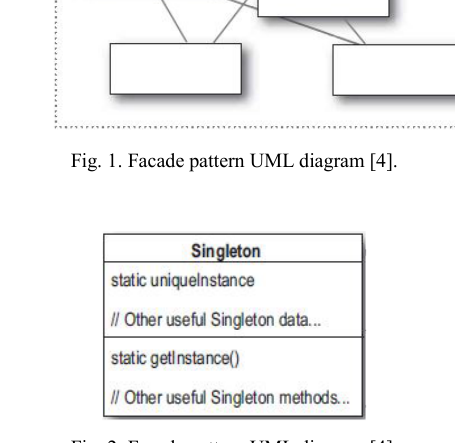
Fig. 2. Facade pattern UML diagram